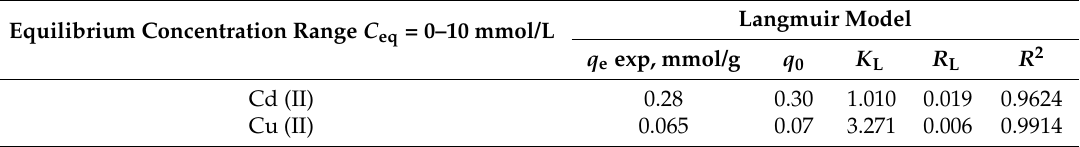
Table 1. Langmuir parameters for Cu (II) and Cd (II) adsorption on the surface of the Fe 3 O 4 /SiO 2 - NH 2 -DTPA